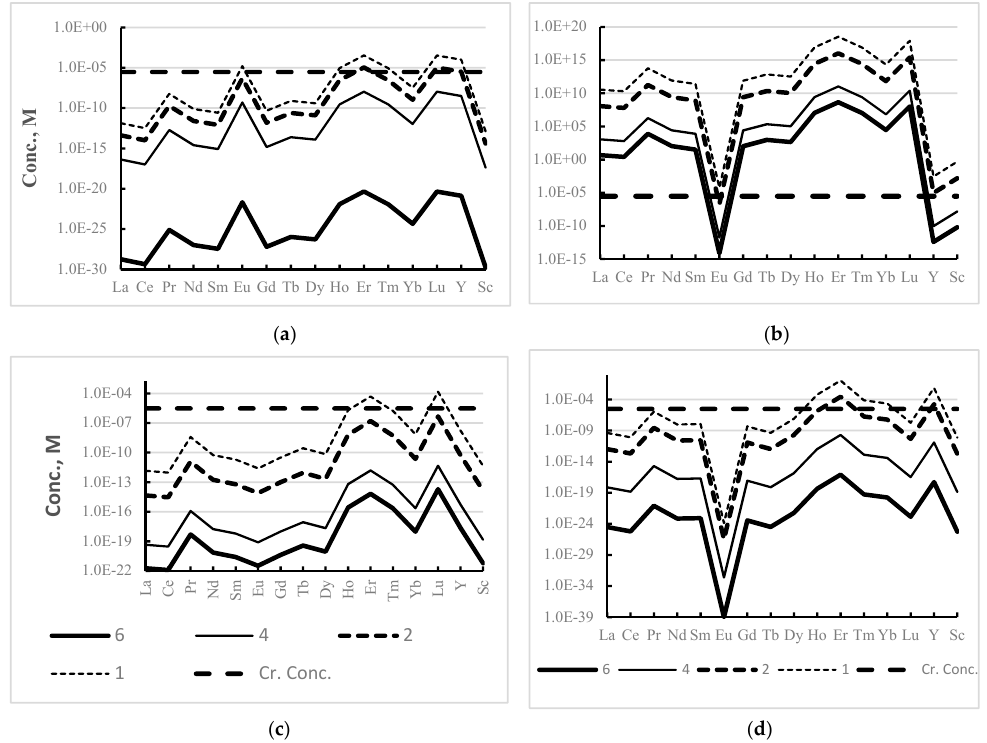
Figure 6. Concentrations of ( a ) Re 3+ , ( b ) ReCl 2+ , ( c ) Re(NO 3 ) 2+ , and ( d ) Re(SO 4 ) 2 − in equilibrium with oxalate precipitate with 10 − 4 M of total concentration of oxalate in solution at pH 6, 4, 2, and 1. Cr. Concentration: 1 ppm line as a target concentration.